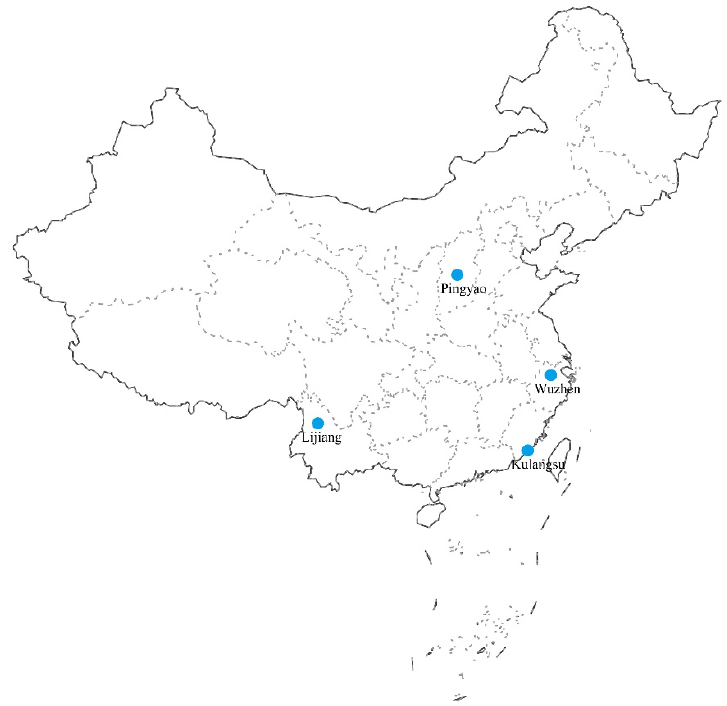
Figure 3. The locations of the four selected HCTs.